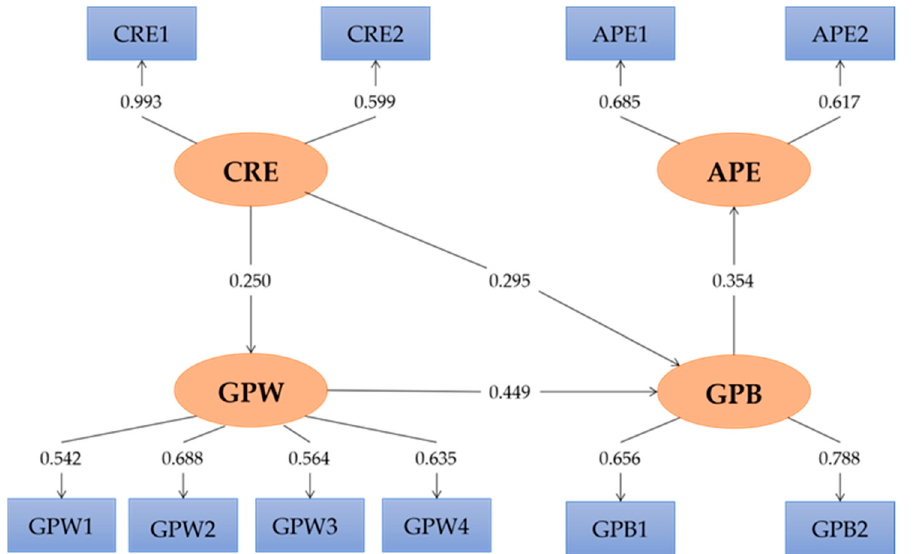
Figure 5. Structural equation model with standardized path coefficients.